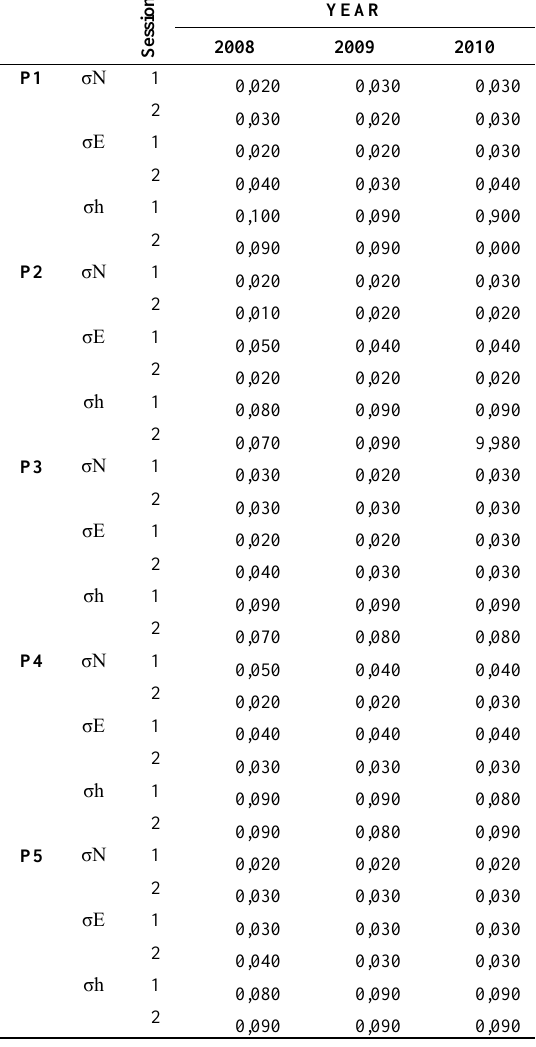
Table 2. Standard deviation of GPS measures.